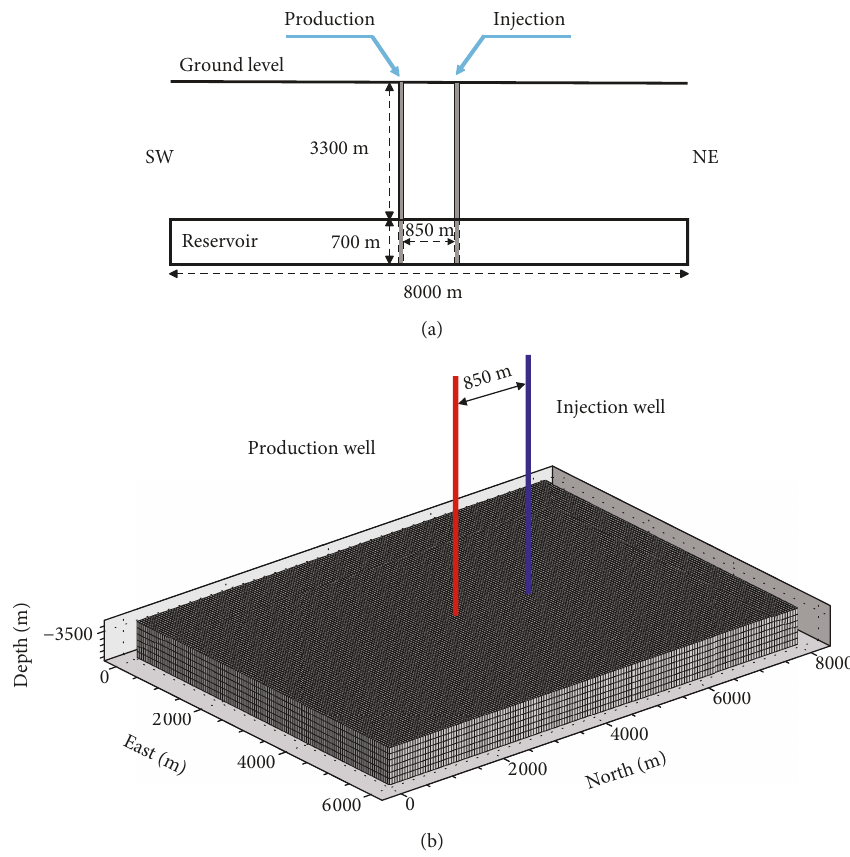
Figure 4: (a) Lateral 2D cross section of the model and (b) well placement in the model domain and discretization. Table 4: Geological and thermophysical parameters of